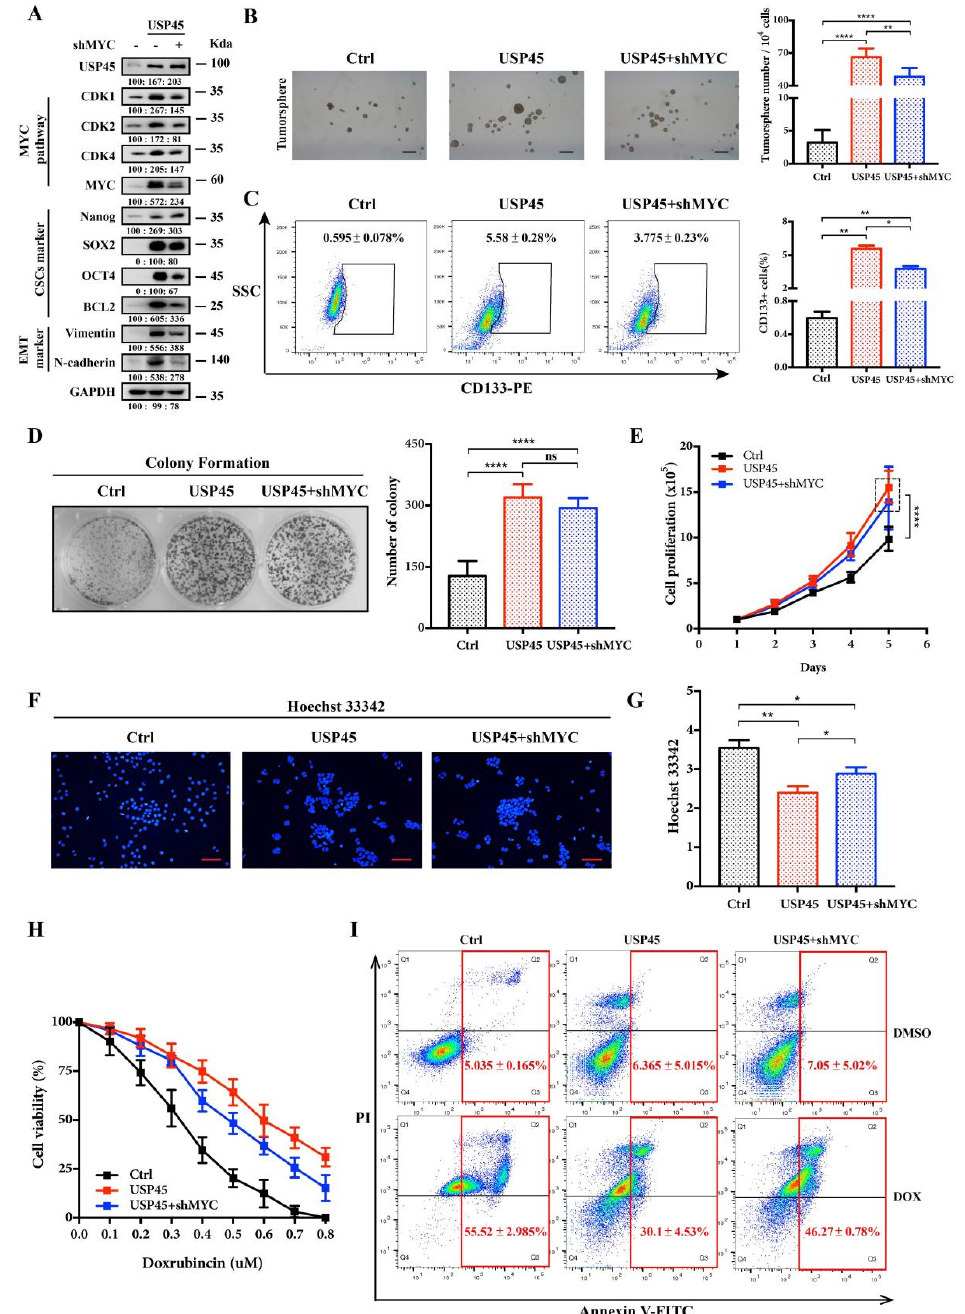
Figure 4. MYC is involved in maintaining the stemness and drug resistance of USP45-mediated cervical CSCs. ( A – E ) SiHa cells stably expressing plvx-puro/pLKO.1-GFP-shRNA (the negative control), USP45 and either shMYC were subjected to ( A ) Western Blot analyses, ( B ) tumorsphere formation assay, ( C ) FACS analyses for CD133-stained cells, ( D ) colony formation assay, ( E ) cells proliferation assay and ( F , G ) Hoechst 33,342 stain analysis. ( H ) The SiHa cells treated with increasing concentrations of doxorubicin (DOX) were subjected to cell viability assay. ( I ) The SiHa cells treated with 0.5 µM DOX for 48 h were subjected to apoptosis analysis by Annexin V/PI staining. Respective images and quantitation were shown. Data from independent experiments in duplicates were presented as means ± SD: p > 0.05 (no significance/ns), * p < 0.05, ** p < 0.01, **** p < 0.0001. Scale bar is 100 µm. Experiments were conducted at least two times in duplicates.